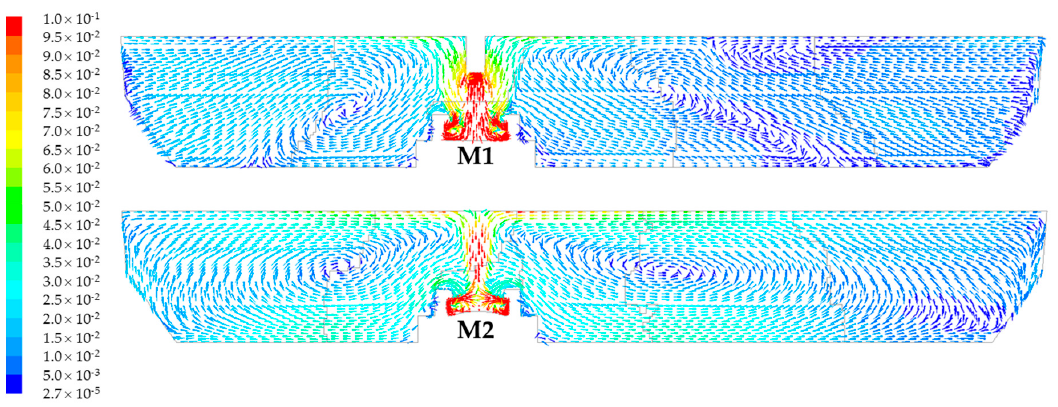
Figure 4. Comparison of velocity vectors (m·s − 1 ) for two tundish configurations in longitudinal sections through the centre of the shroud tube.